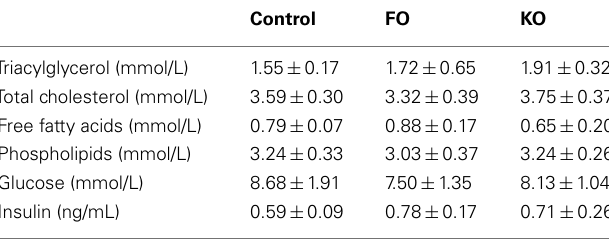
Table 2 | Effect of FO and KO on selected plasma